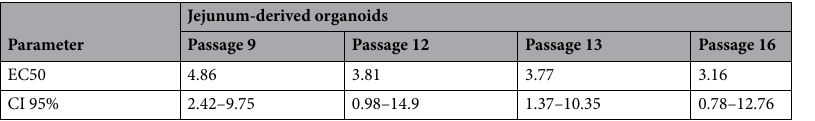
Table 1. Stability of NF-κB reporter activity from jejunum-derived organoids. Organoids were stimulated with TNF-α during 24 h at different passage numbers. The NF-κB activation was measured by detection of luciferase activity. EC50 and its 95% confidence interval (ng/mL) were calculated using non-linear regression 3-parameter fit with GraphPad